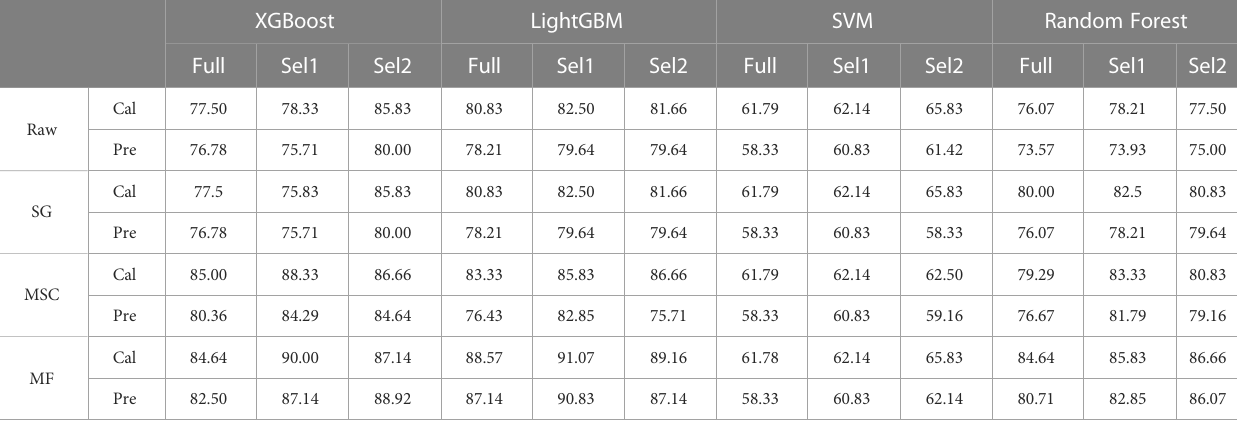
TABLE 2 Seed vitality classi fi cation results